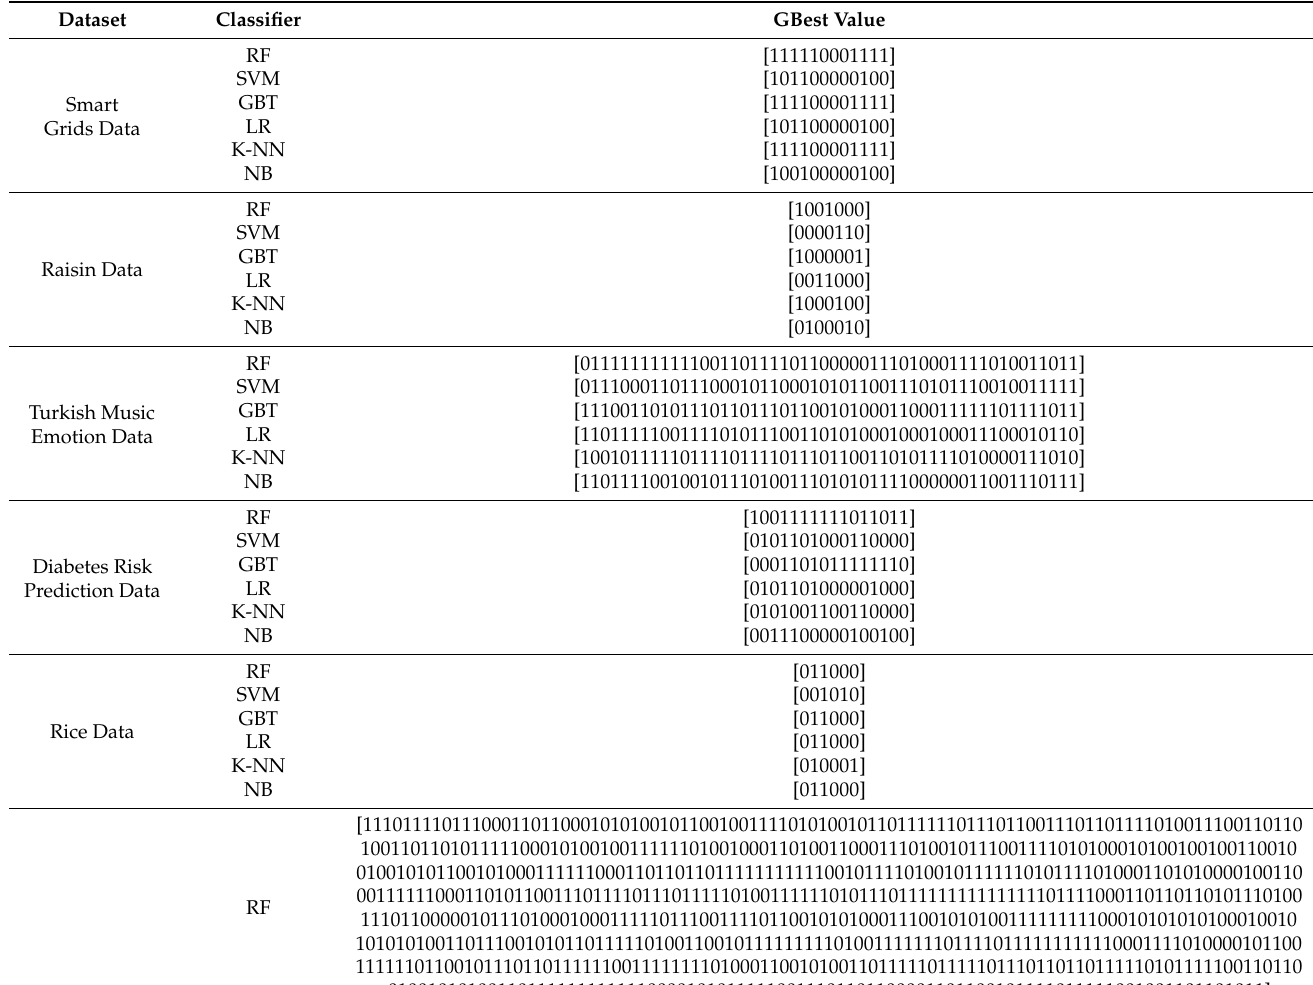
Table 12. BGWO GBest Values Results